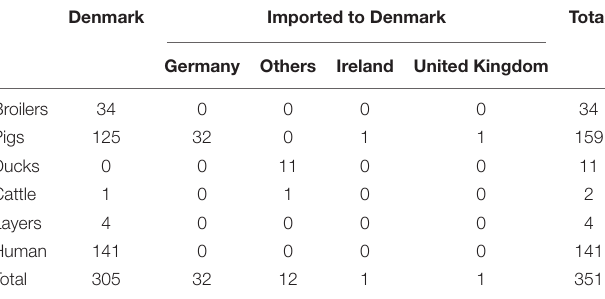
TABLE 3 | Data set composition according to primary source and country of sample